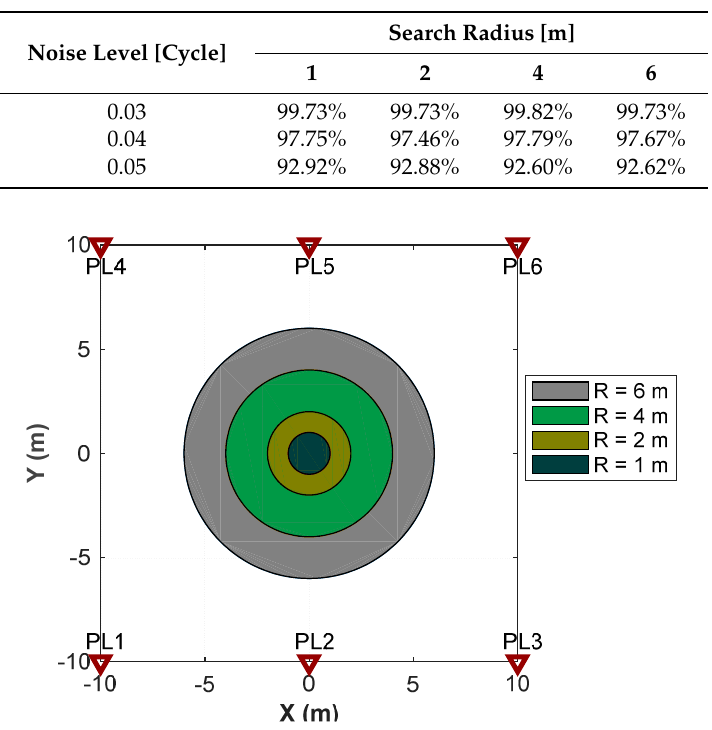
Table 1. Success rates for the kinematic ME-MAFA, as function of the phase noise levels and the circle radius of the search region.